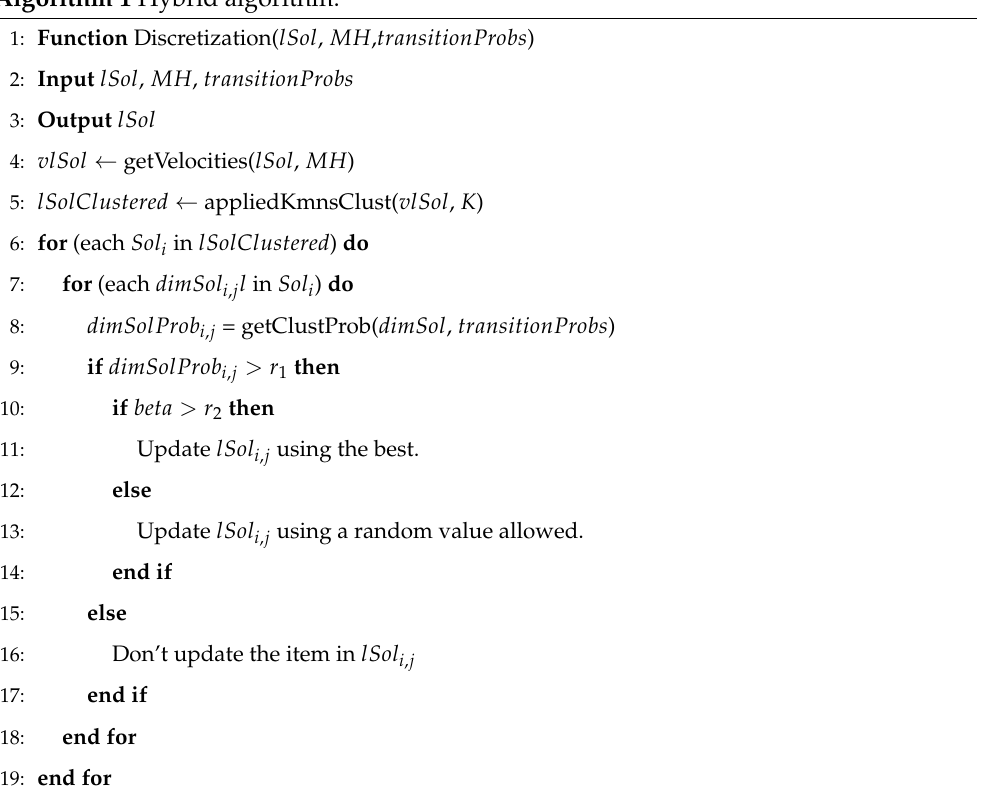
Algorithm 1 Hybrid algorithm.